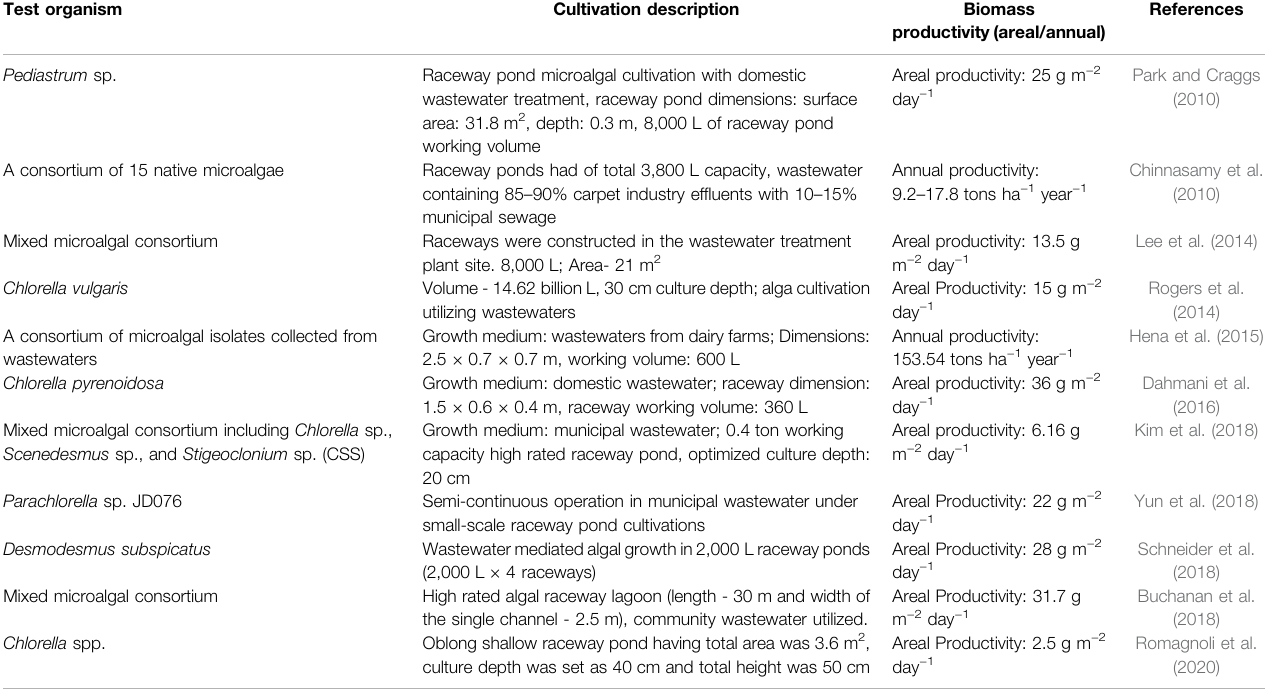
TABLE 2 | Review on biomass productivity of various microalgal species with the utilization of wastewaters as growth medium under raceway pond cultivation. Test organism Cultivation